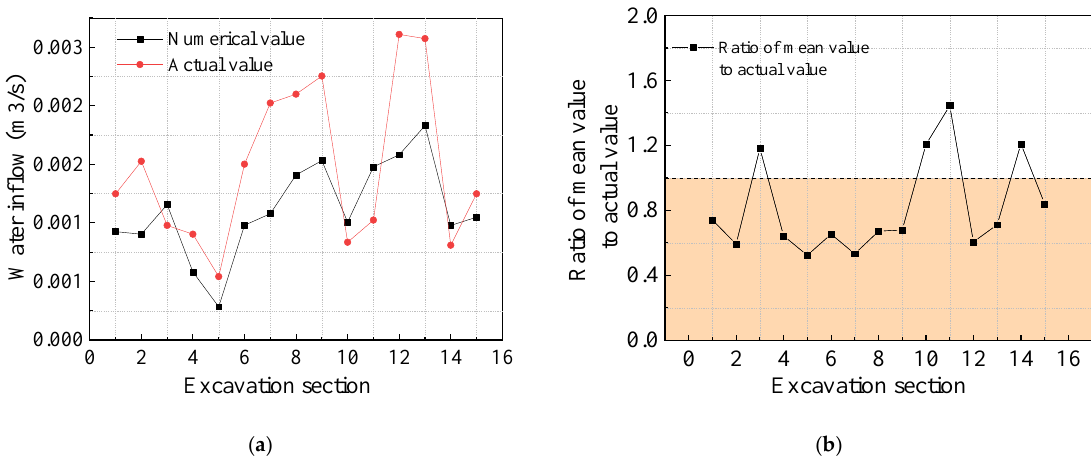
Figure 15. Comparison of simulated and measured values for slurry excavation of shaft No. 1. ( a ) Comparison of simulated and measured values, ( b ) Ratio of simulated to measured values. Where 1 to 15 is same to above.